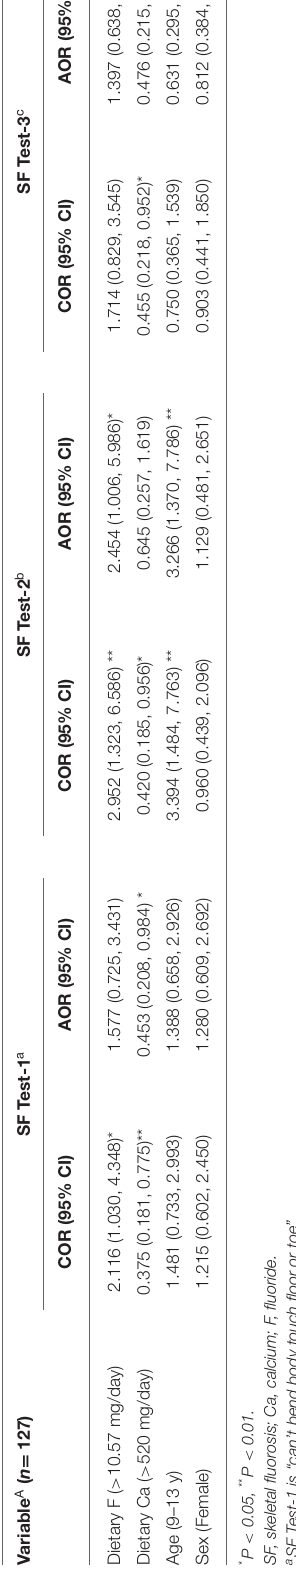
TABLE 5 | Predictors of dental fluorosis (DF) among school children using calcium (Ca) and fluoride (F) intakes from 24-h dietary data: logistic regression model, Halaba zone, SNNPR Ethiopia,